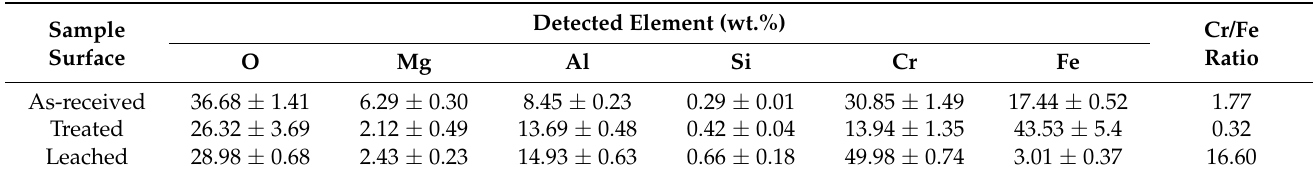
Figure 4. Backscattered electron SEM micrographs of the surface of as-received chromite ( a ), 800 times magnification), hydrogen-treated chromite ( b ), 800 times magnification), and acid-leached hydrogen-treated chromite ( c ), 1300 times magnification). Table 3. Microanalyses of chromite particles by SEM–EDX (wt.%). A minimum of eight randomly selected particles were considered and between three to five areas were analyzed with the averages and standard deviations indicated. The Cr/Fe ratio is also indicated.